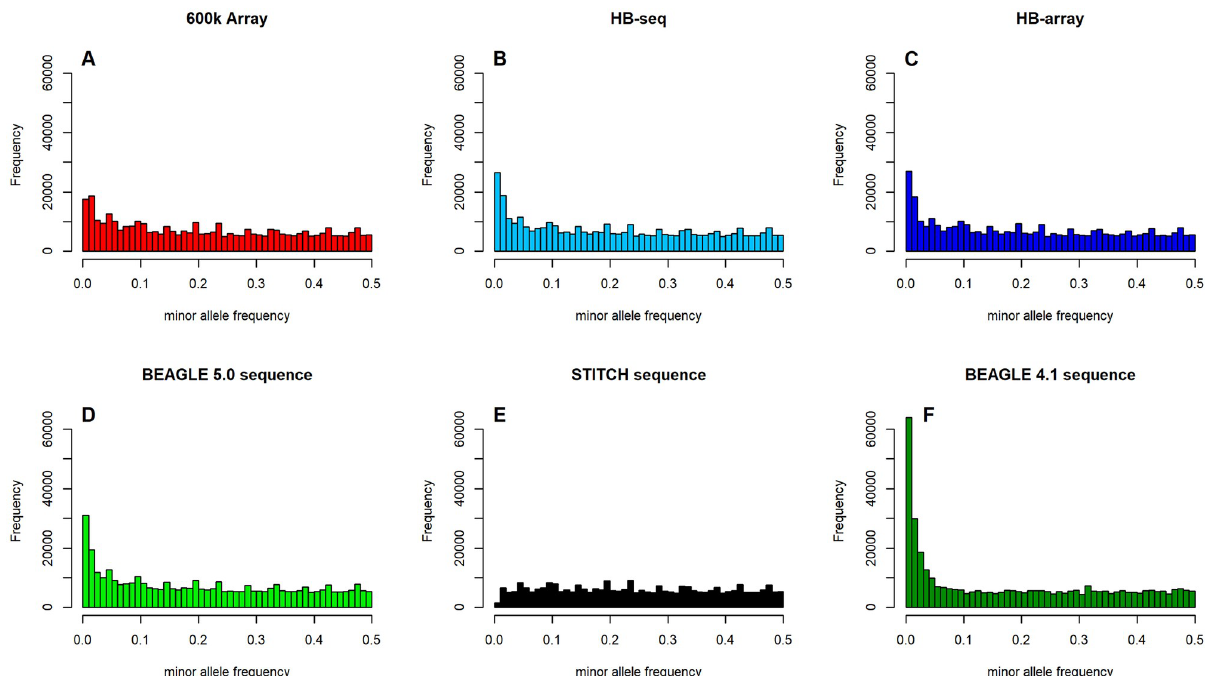
Fig 3. Allele frequency spectrum of the genomic datasets for all bivarite markers that are shared between the array and sequence data panels.